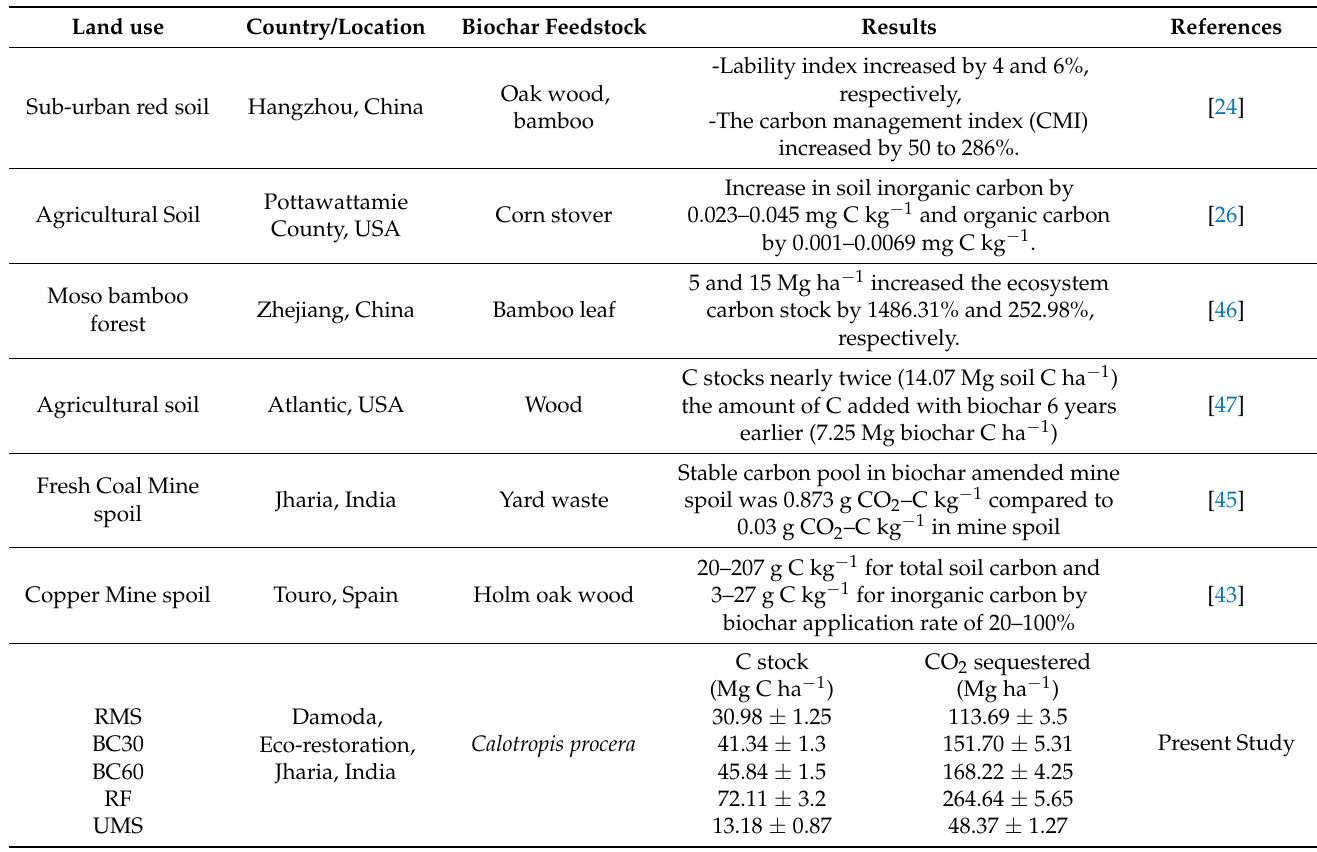
Table 4. Effect of biochar application on carbon stocks of different landforms. Comparison of total C stock, CO 2 sequestered, Rate of C accumulation in 8 year old RMS (reclaimed mine spoil), BC 30 (biochar @ 30 t ha − 1 ), BC 60 (biochar @ 60 t ha − 1 ), RF (reserve forest) and unreclaimed mine spoil